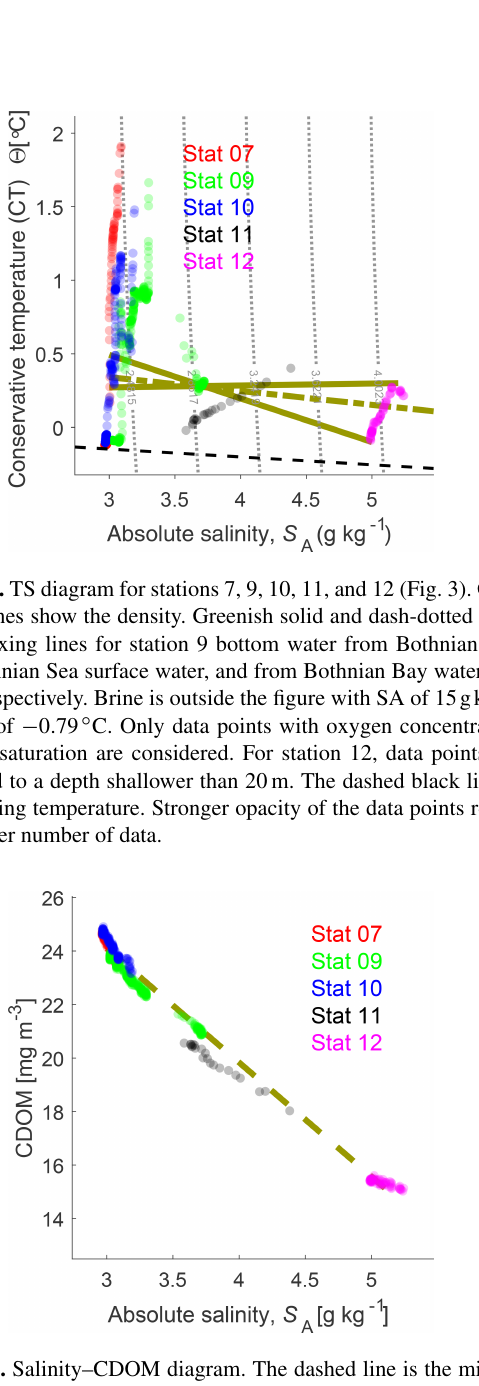
Figure 9. Salinity–CDOM diagram. The dashed line is the mixing line. Stronger opacity of the data points refers to a higher number of data. Data of station 7 are mostly covered by station 9 and 10